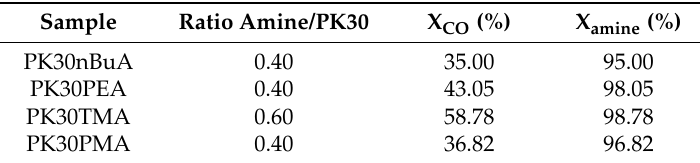
Table 2. Ratio of amine/PK30 in alimentation, the carbonyl conversion (X CO ), and the amine conversion (X amine ) calculated according to Equations (1) and (2),